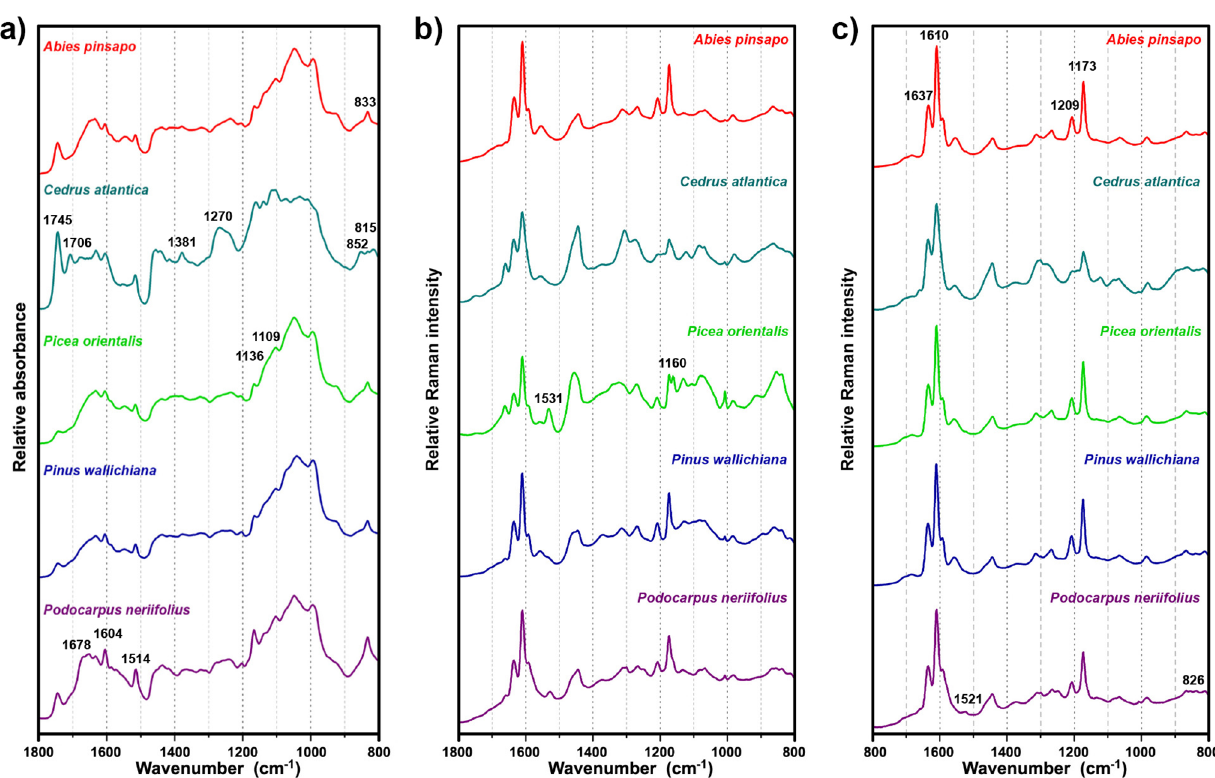
Fig 2. Spectra of representative samples of pollen measured as: (a) ATR of ground pollen, (b) Raman of corpus region, and (c) Raman of saccus region. The spectral set consists of EMSC normalized average spectra; for better viewing the spectra are